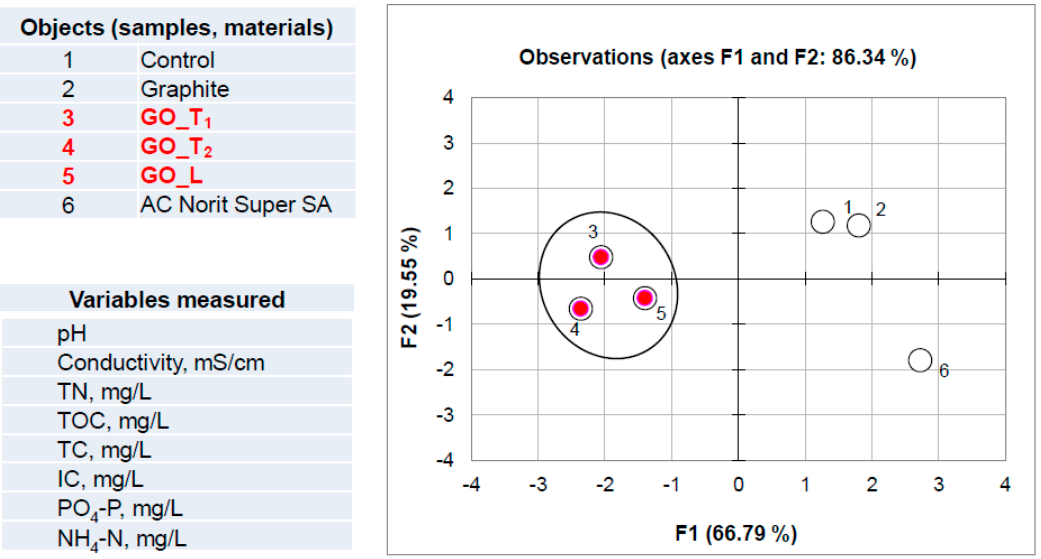
Figure 8. Projection of the objects set in 2D factor score space concerning PCA analysis of data matrix consisting of physicochemical parameters of wastewater, related to the experiment involving wastewater and activated sludge with carbon materials.